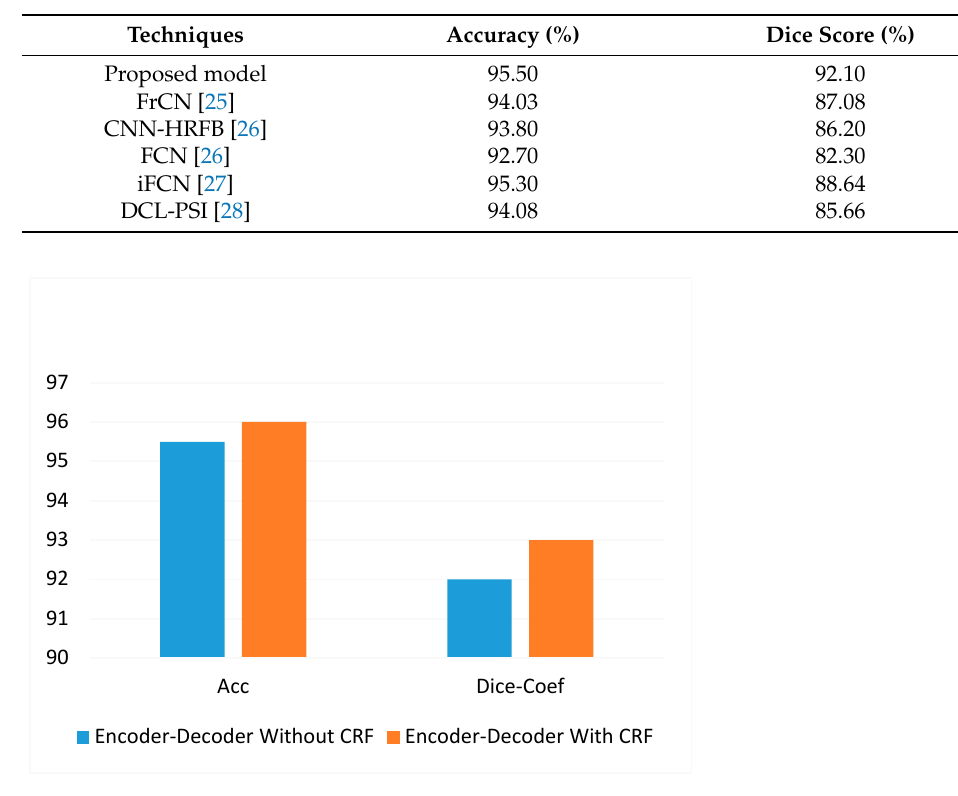
Figure 10. Recognition accuracy and loss curves of the comparison models: ( a ) model test accuracy comparison and ( b ) model loss comparison. As can be seen from Table 3, the test accuracy of the VGG16 model was 81.98%, which was obviously not suitable for this experiment. The recognition accuracy of the VGG19